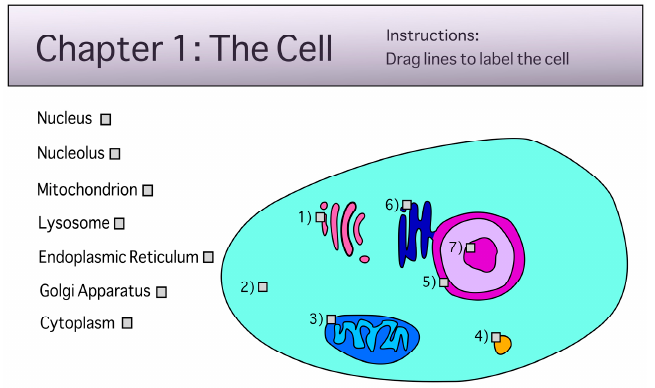
Figure 5. An image-labeling question.